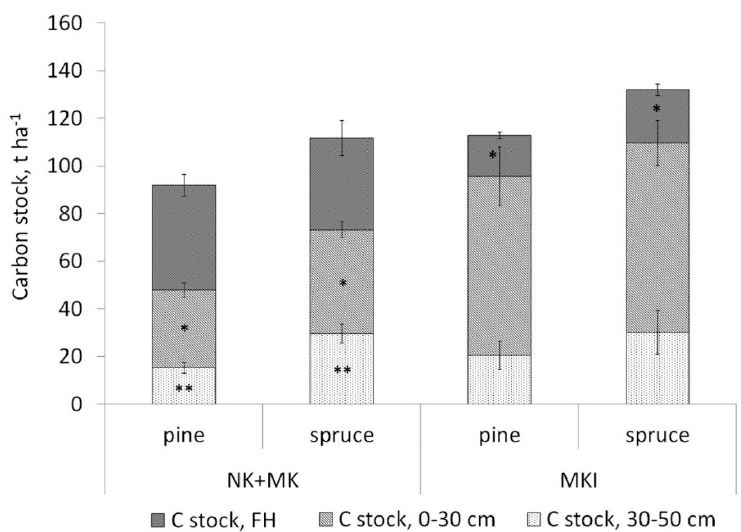
Figure 6. Soil carbon stocks in pine ( n = 34) and spruce ( n = 17) Karelian forests (NK + MK) on Carbic Albic Podzols and in pine ( n = 23) and spruce ( n = 14) forests on Albic Retisols in the Karelian Isthmus (MKI). The significance of the differences between the mean in category and overall mean was estimated taking into account the areas (NK + MK and MKI).